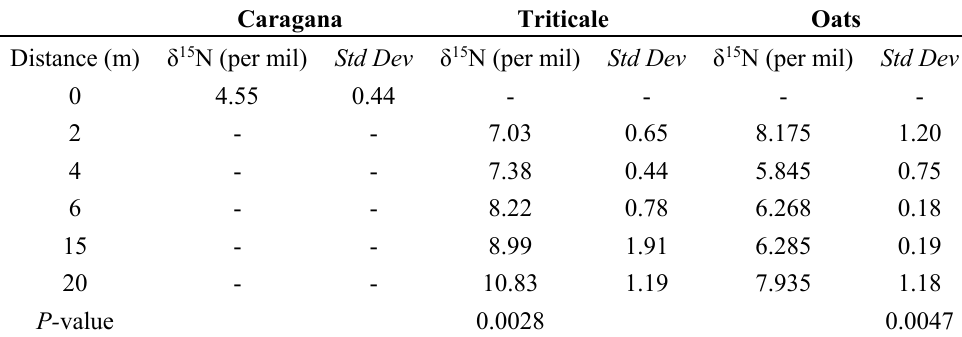
Table 2. Delta 15 N values of leaves (caragana) or shoots (triticale and oats) where triticale and oats are grown adjacent to a mature caragana shelterbelt row (distance 0) and sampled at perpendicular distances away from the